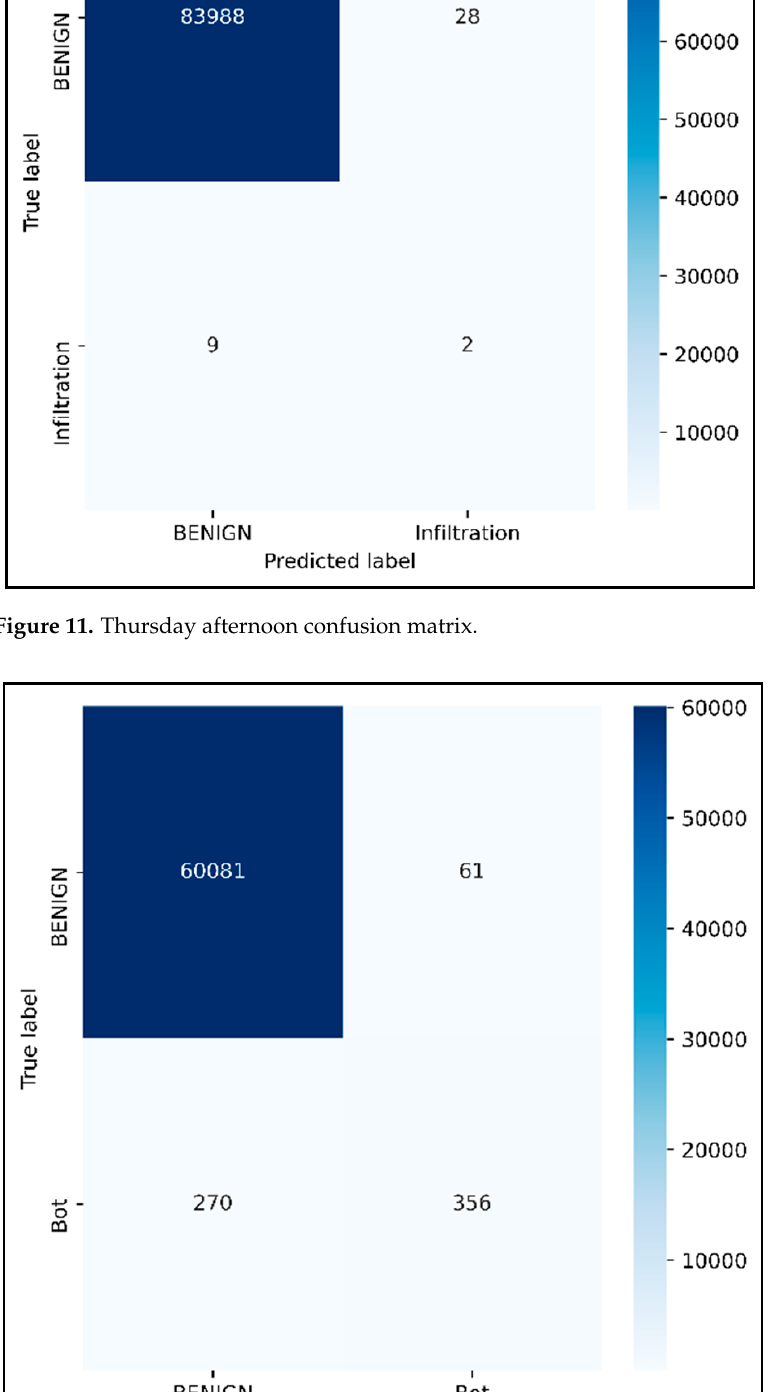
Figure 12. Friday morning confusion matrix.